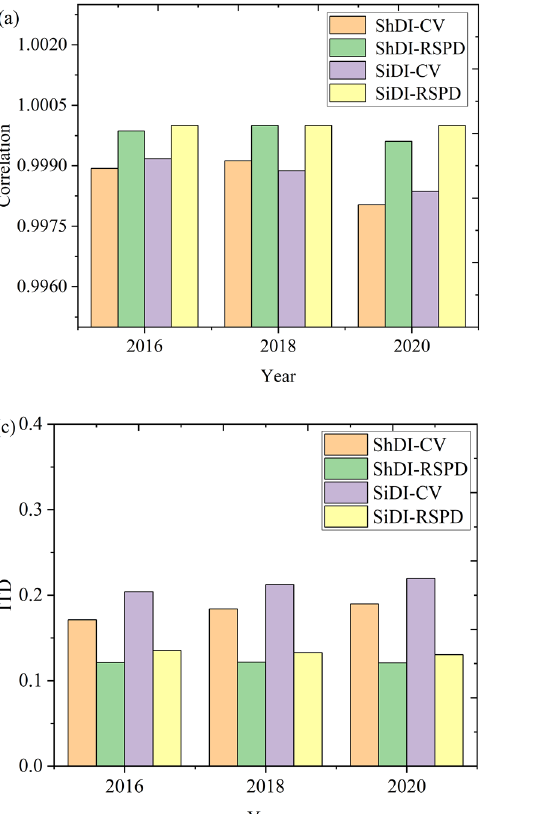
Figure 5. Spatial distribution of ShDI and SiDI based on Sentinel ‐ 2 data where ( a – c ) are ShDIs in Case I on 28 August 2016,